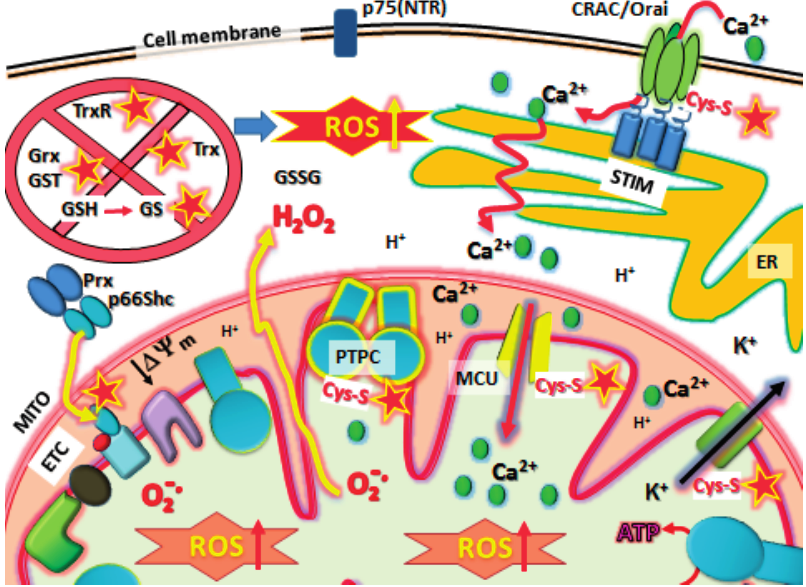
Figure 4. NSAID target sites for Cysteine-Thiol (Cys-S) reactivity in metastatic